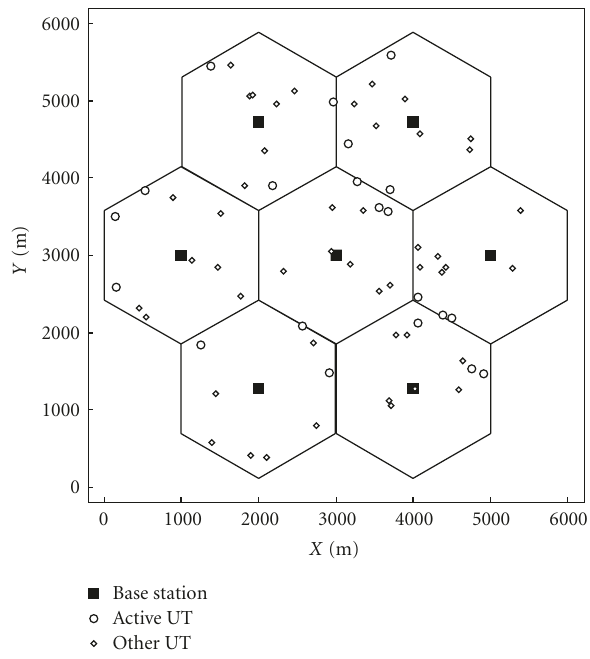
Figure 10: Macrocell network topology composed of N BS = 7 hexagonal cells with N UT = 3 active UTs per cell.